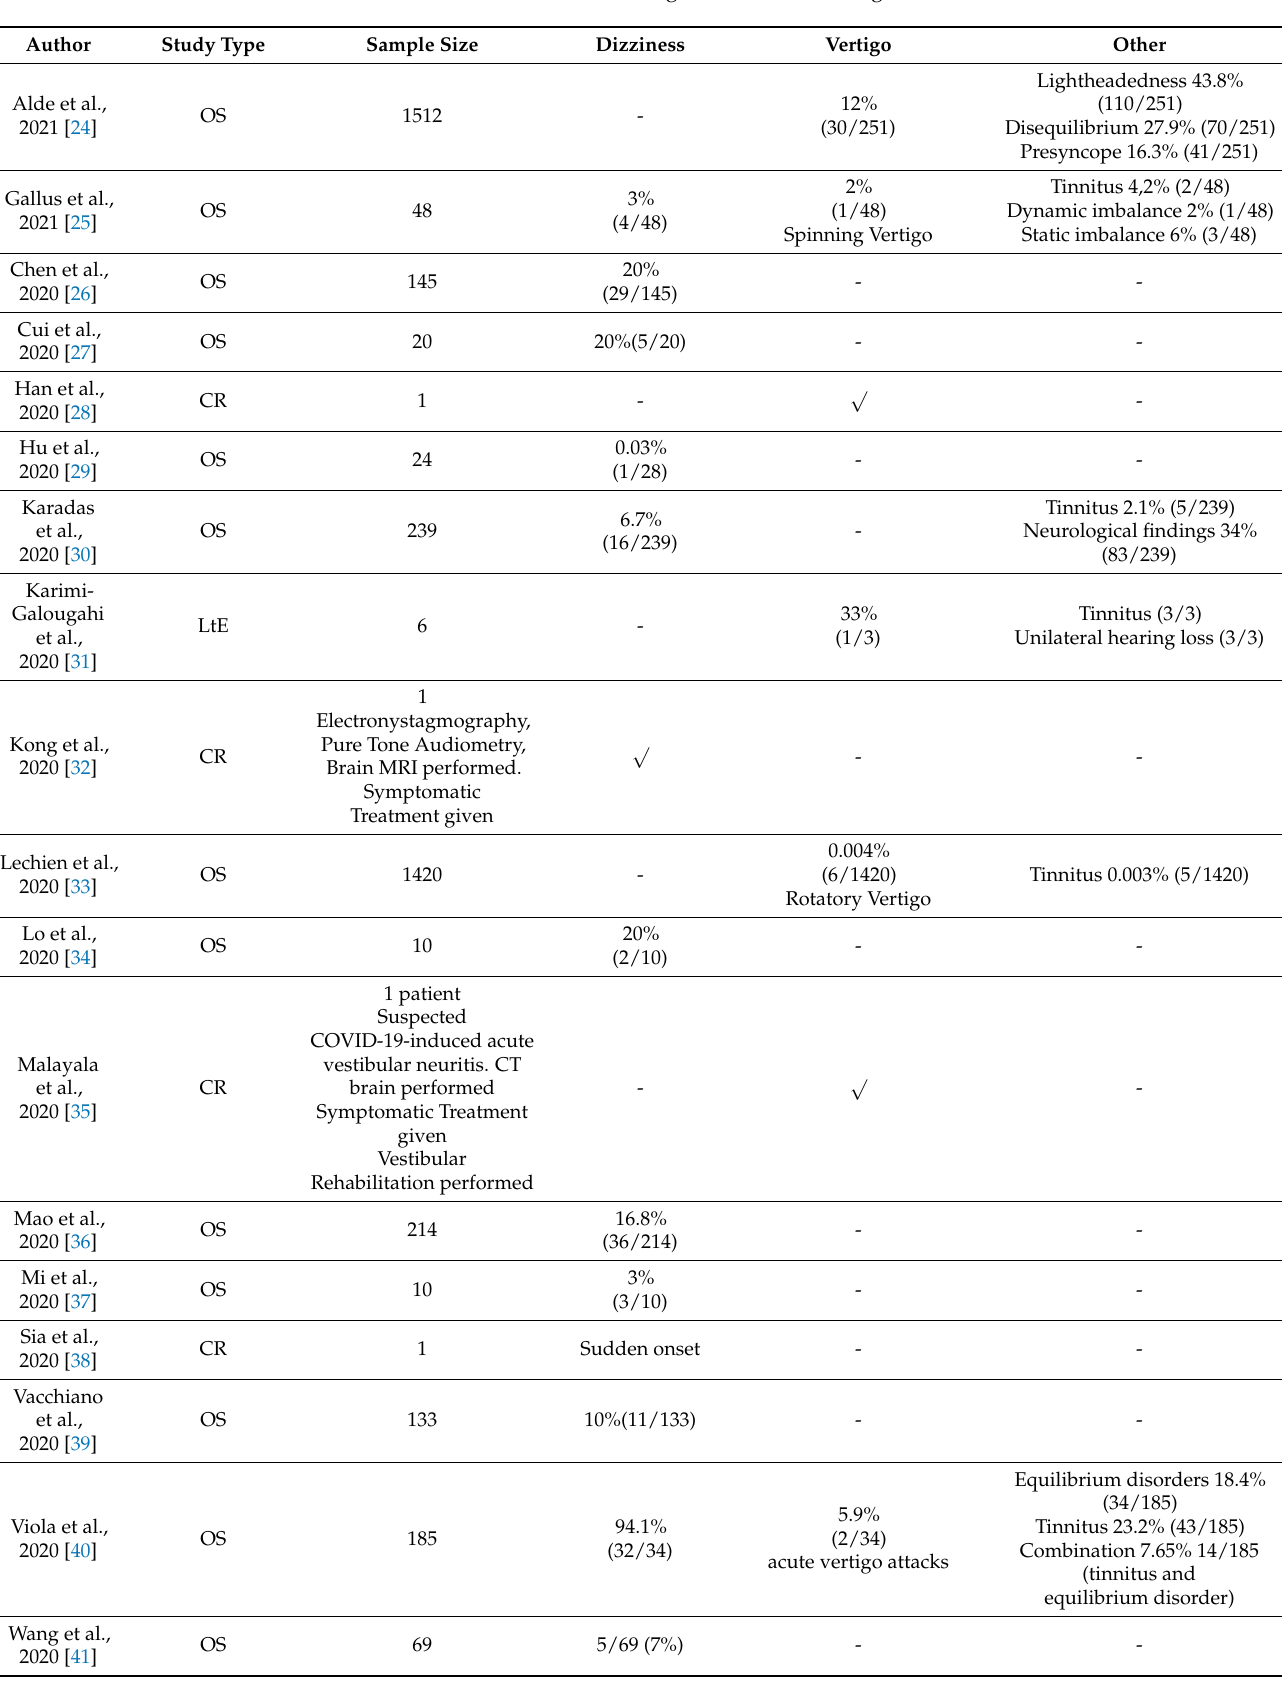
Table 1. COVID-19 studies including dizziness and